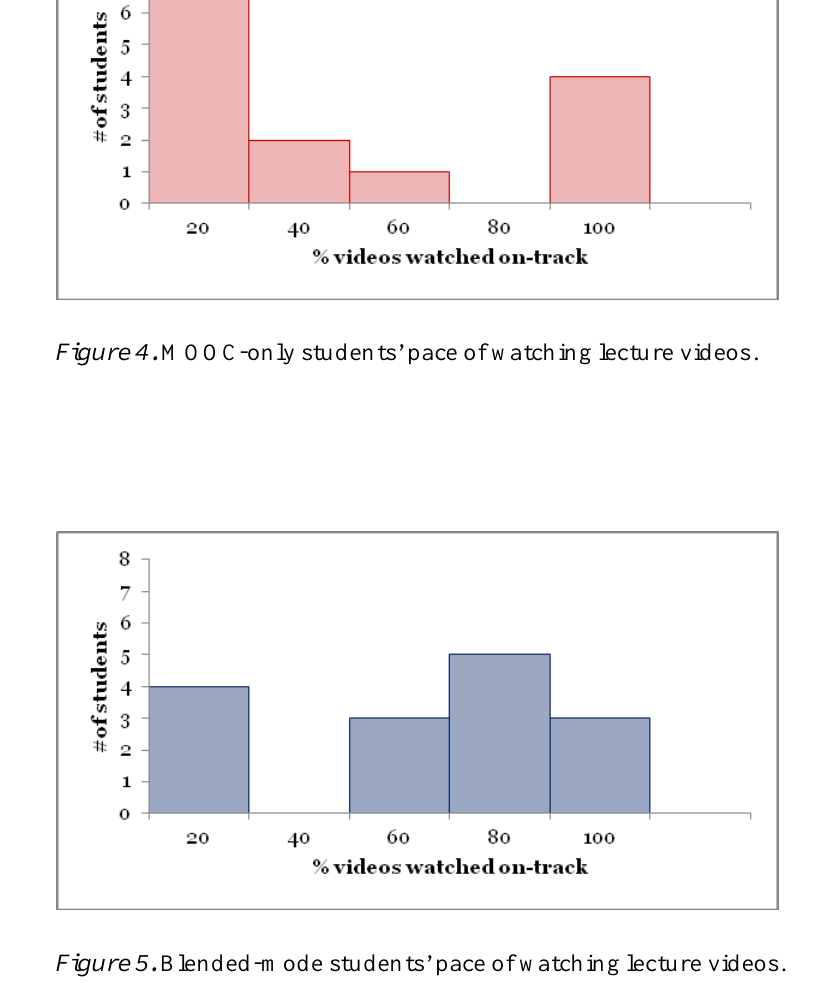
Figure 5. Blended-mode students’ pace of watching lecture